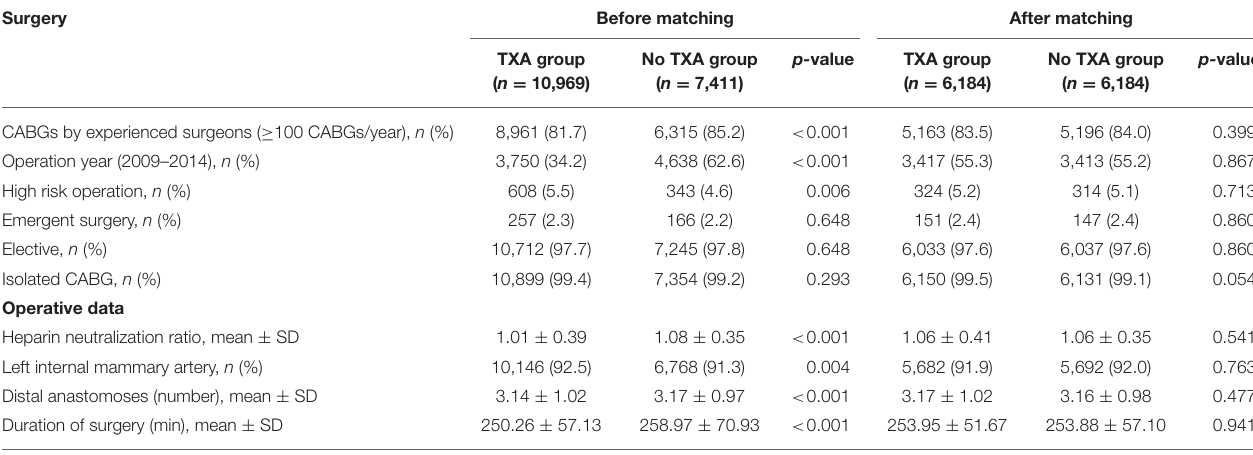
TABLE 2 | Surgical and other perioperative characteristics of the patients in the tranexamic acid and no tranexamic acid groups before and after propensity score matching. Surgery Before matching After